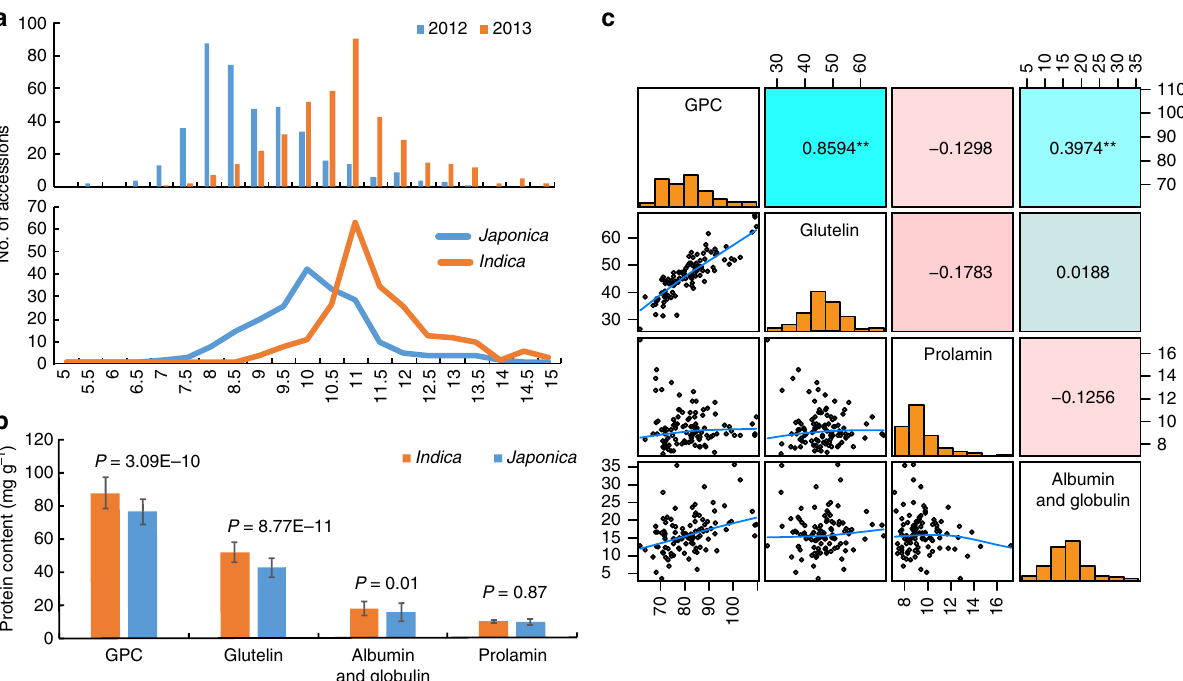
Fig. 1 Indica varieties show higher GPC and glutelin contents than japonica varieties. a The distribution of GPC among 402 accessions in 2012 and 2013, and the distribution of GPC within the subspecies indica and japonica in 2013. b Comparison of GPC and storage protein fraction between the 43 conventional indica varieties and 60 japonica varieties. Error bars, s.d. P -values were calculated by independent-samples t -test. c The pairwise correlation analysis among four total kinds of protein content. Upper diagonal: Pearson correlation coef fi cients between every two traits; lower diagonal: Scatter plots of correlations between every two traits. Double asterisks (**) indicates signi fi cance level at P <